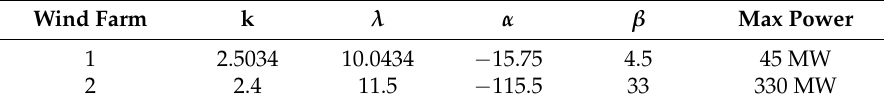
Table 1. Parameters of two